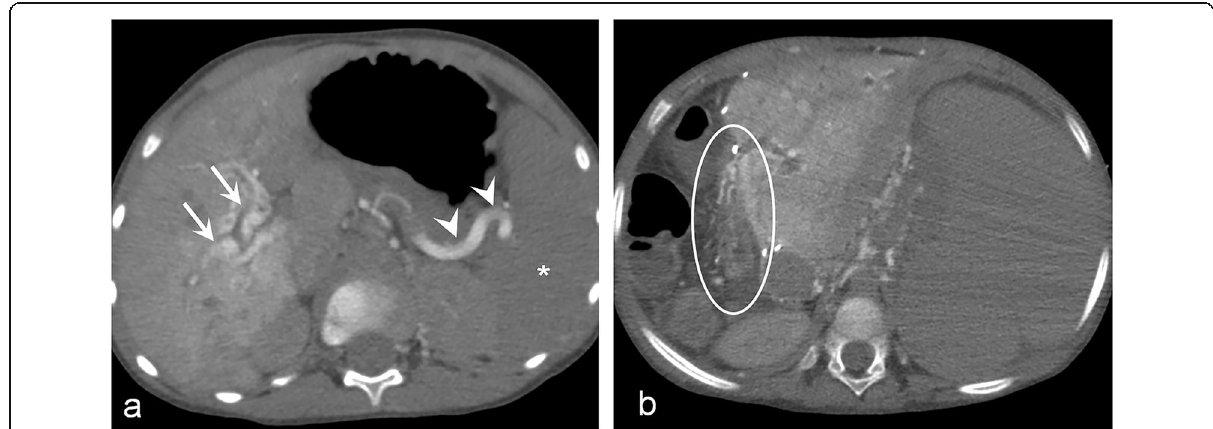
Fig. 1 Computed tomography arterioportography (CT AP) findings in two different children. a A 5-year-old male patient with portal vein thrombosis. Axial images obtained after contrast injection in the superior mesenteric artery detect portal biliopathy (arrows) and reversed blood flow in the splenic vein (arrowheads). The spleen does not show contrast enhancement (white asterisk). b An 8-year-old male patient with portal vein thrombosis after liver transplantation. CT AP shows varices and diffuse enhancement of the hepaticojejunostomy